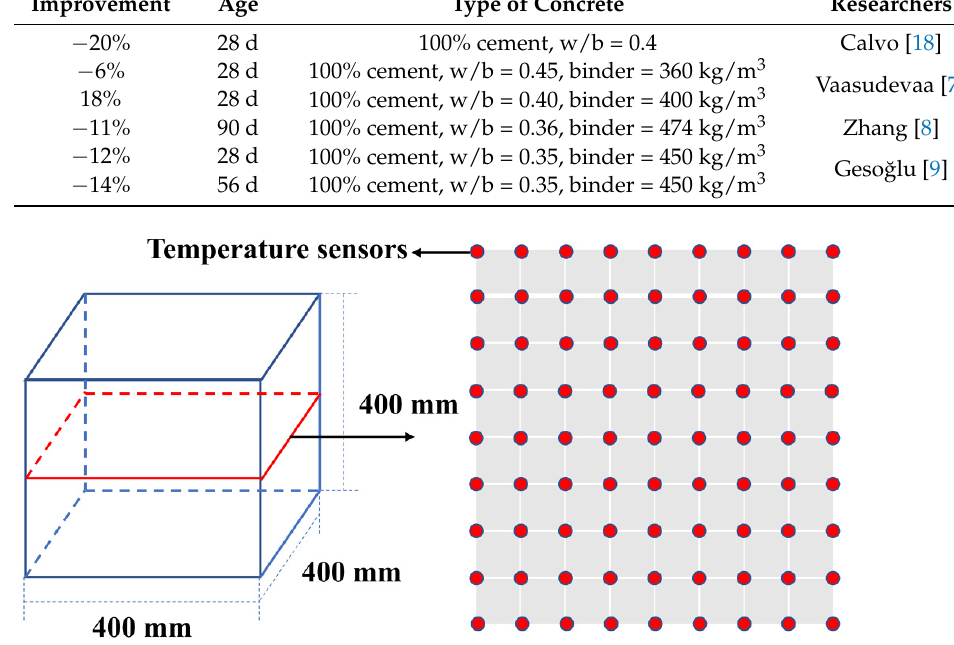
Figure 3. Thermal damage test of PC [20].